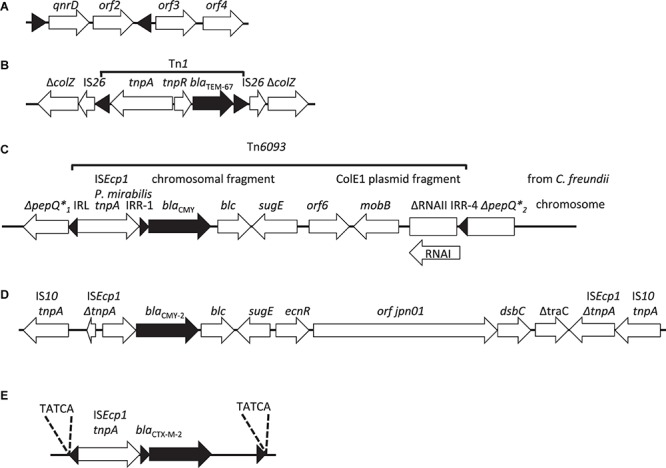
Schematic representation of the structure containing (A) the qnrD gene in P. rettgeri pDIJ09-518a on a non-transmissible plasmid, the right (IRR) and left (IRL) repeated inverted sequences also named “mobile insertion cassette” elements (mic), used for mobilization of qnrD, are indicated by black triangles (Guillard et al., 2014); (B) the blaTEM–67 gene in Tn1 flanked by two IS26 on the non-transferable plasmid of P. mirabilis NEL (Naas et al., 2003); (C) the blaCMY gene within the ISEcp1: Tn6093 transposition module inserted into the pepQ gene of P. mirabilis (D’Andrea et al., 2006); (D) the blaCMY–2 gene inserted into ICE R391 from P. mirabilis PmiJpn1 (Harada et al., 2010); (E) the blaCTX–M–2 gene located on the chromosomes of P. mirabilis TUM4657 (Harada et al., 2012), the 5 letters correspond to the direct repeat sequences (DRL and DRR). The β-lactamase genes and their orientation are represented by black arrows and the IS by black triangles, including the IR-R and IR-L of ISEcp1 and the IR-R of the ISEcp1 transposition unit.